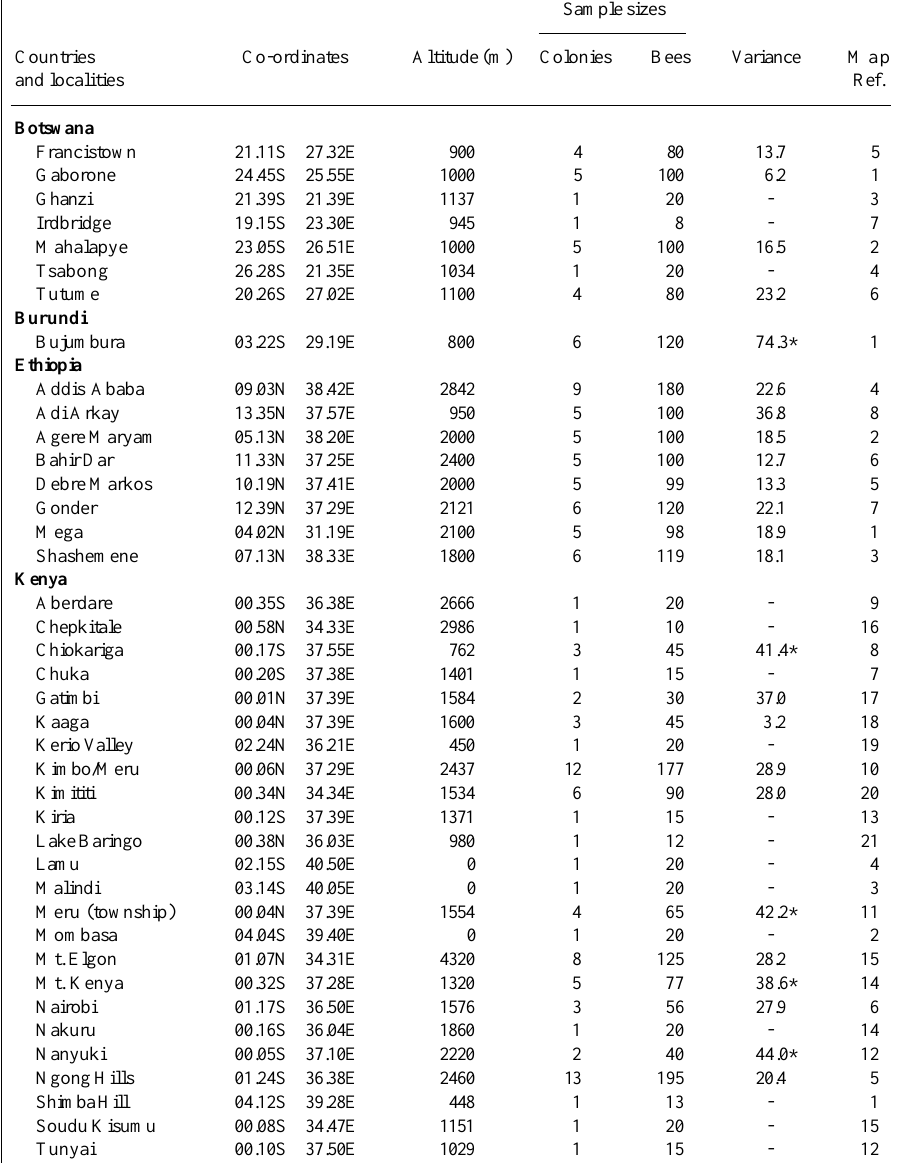
Table I - Distribution of the localities, co-ordinates, altitudes, sample sizes and intercolonial variances of worker honeybees analysed morphometrically. Sample sizes Countries Co-ordinates Altitude (m) Colonies Bees Variance Map and localities Ref.